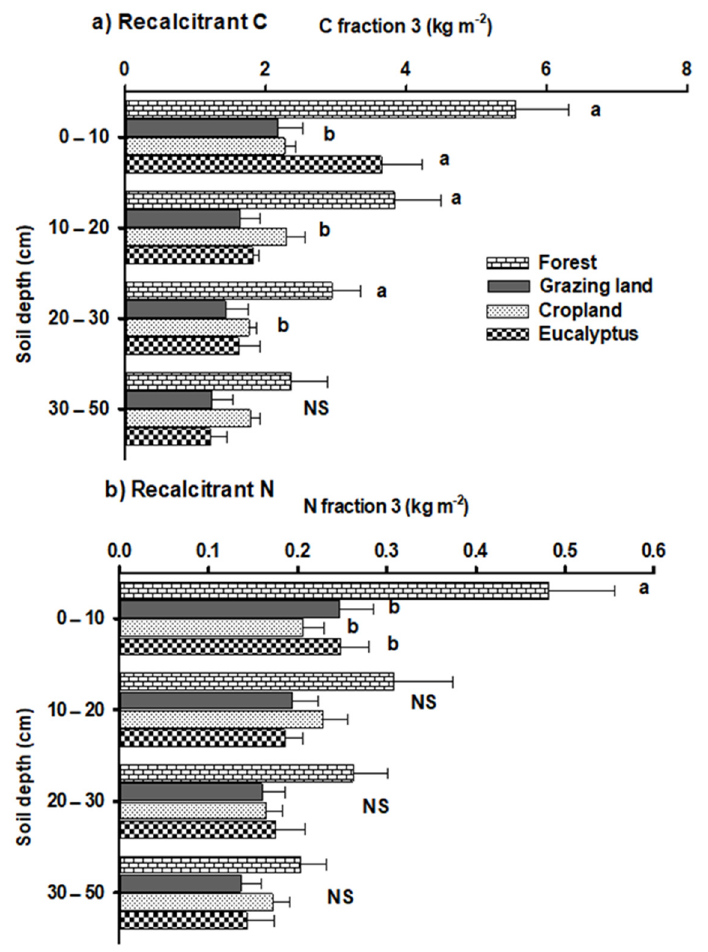
Figure 4. Vertical distributions of recalcitrant C and N (fraction 3) in soils of natural forest, grazing and crop lands and eucalyptus plantation. ( a ) Recalcitrant C stock and ( b ) recalcitrant N stock, representing unhydrolyzed fractions of soil organic matter from acid hydrolysis. Bar means stock ( n = 5, ± SE), bars without same alphabet are statistically significant ( p ≤ 0.05), NS, non-significant. Table 3. Relative concentration of difference SOM fractions under different land-use. C and N fractions at each depth were comparable along four land-use types. Values equal mean ( n = 5, ± SE). Different alphabets indicate variations between two land-use types are statistically significant ( p ≤ 0.05).